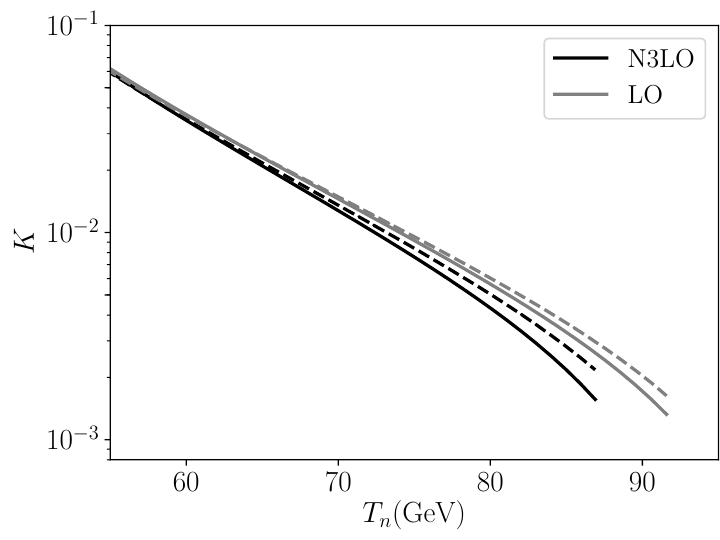
Figure 5 . Absolute value of K as a function of the nucleation temperature for a hybrid ( v w = 0 . 65 ). The black lines indicate the results of the N 3 LO analysis and the gray lines show the result of the one-loop analysis. The dashed lines show the results based on a mapping onto the bag equation of